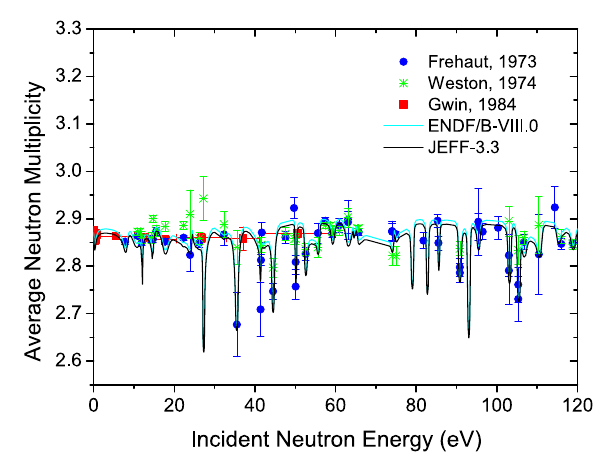
Figure 1. Fluctuations in the average neutron multiplicity as a function of the incident neutron energy in 239 Pu(n,f). Experi- mental data from Refs.